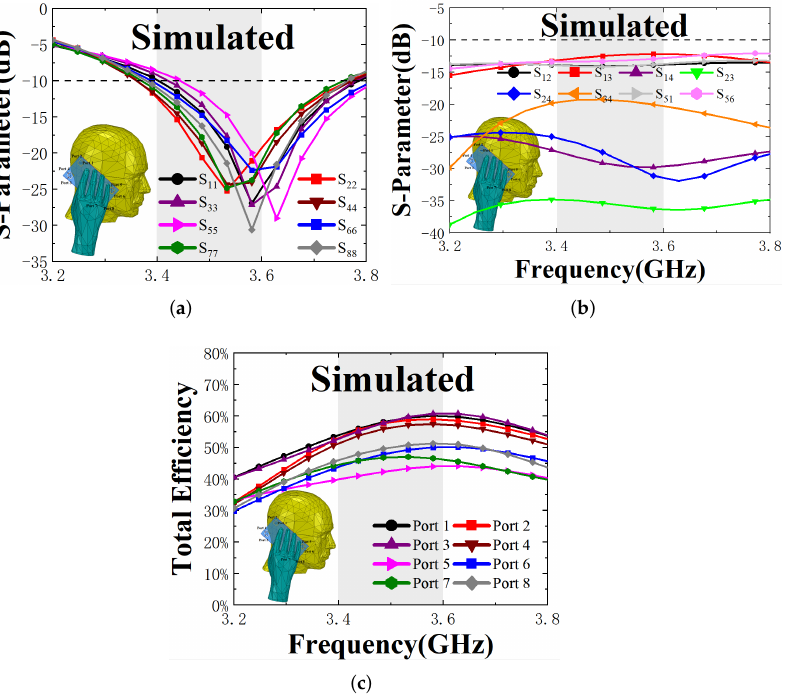
Figure 13. Simulated results of the proposed antenna with single hand and head model. ( a ) Reflection coefficients. ( b ) Transmission coefficients. ( c ) Total efficiency.